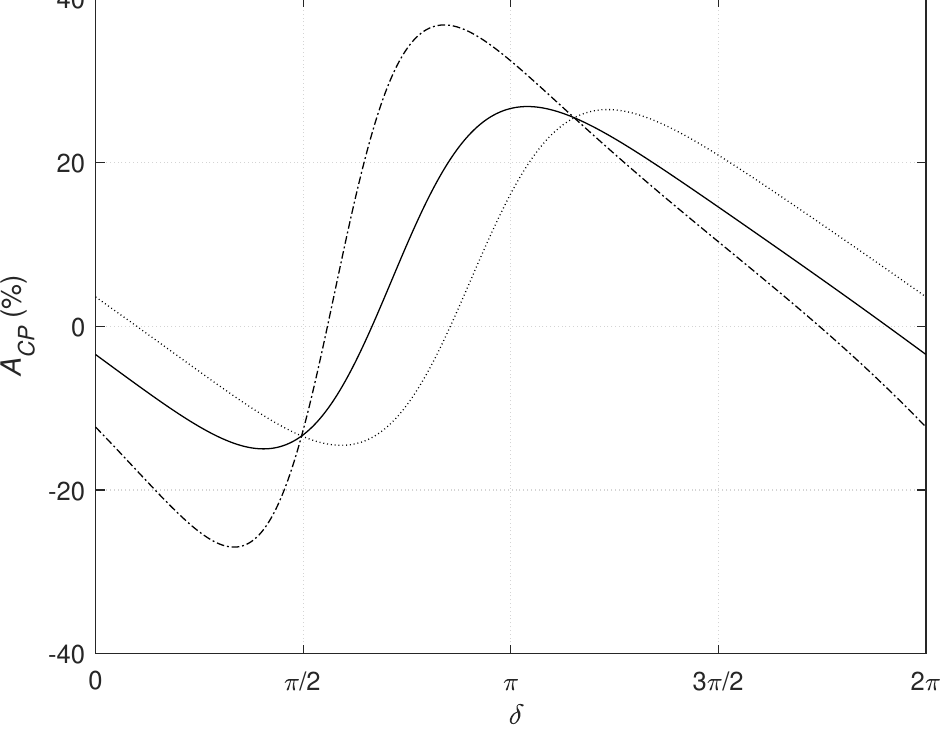
Figure 4 . The PW CP As A (2) resonance ∆ 0 (1232) as a function of the strong phase δ . The solid line is for the situation that s is integrated in the region (( m ∆ − Γ ∆ ) 2 , ( m ∆ +Γ ∆ ) 2 ) , the dotted line is for that (( m ∆ − Γ ∆ ) 2 , m 2 and the dashed line is for that ( m 2